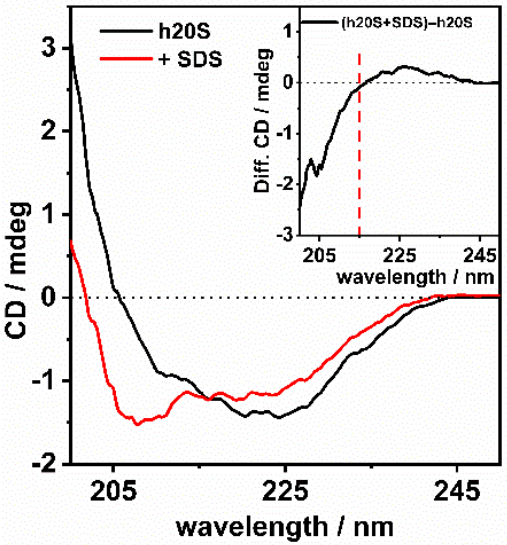
Figure 3. ECD spectra of 25 nM h20S proteasome in 150 mM Tris buffer with 100 mM NaCl at pH 7.6, before (black trace) and after addition of SDS 0.018% (red trace). Inset: ECD difference between the spectra of h20S in the presence of SDS minus that of h20S.